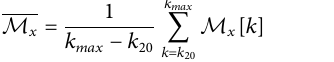
FIGURE 2 Submicroscopic simulation of a group of 20 Khepera IV